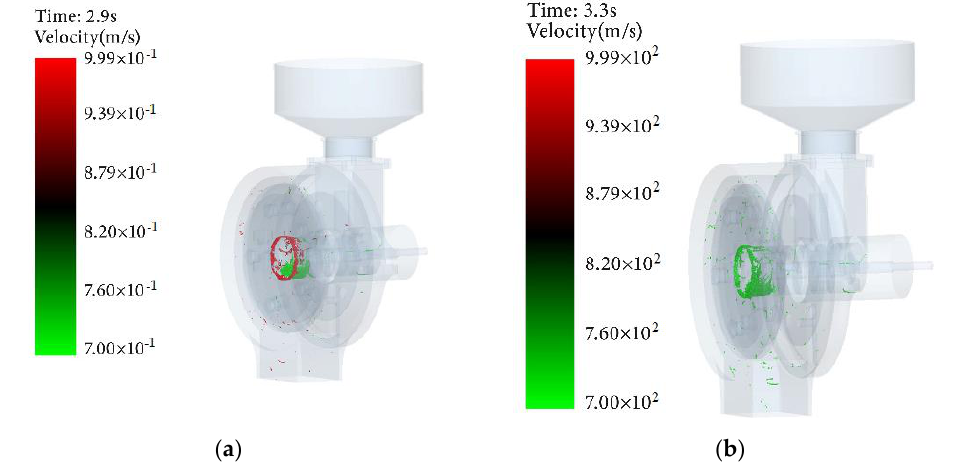
Figure 7. Particle velocity distribution streamline. ( a ) T = 2.9 s particle velocity distribution streamline; ( b ) T = 3.3 s particle velocity distribution